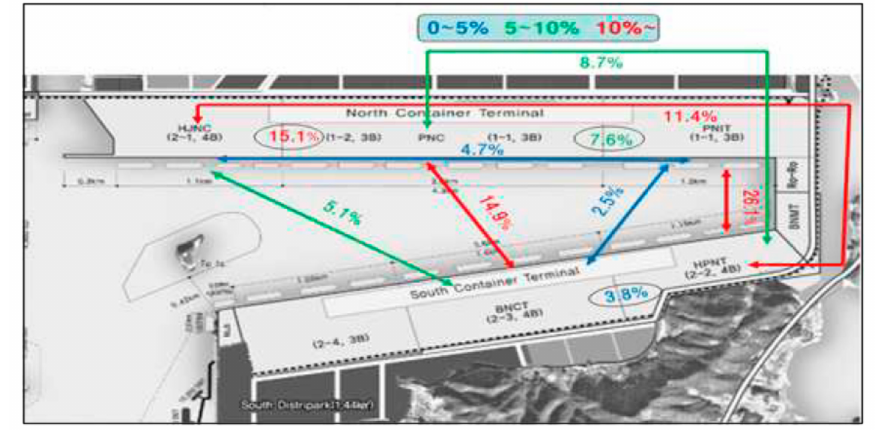
Figure 5. Busan New Port Container Terminal Layout